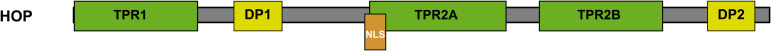
Canonical domain organization of HOP. HOP’s structure usually comprises three TPR domains called (TPR1, TPR2A, and TPR2B), a nuclear localization signal (NLS) that partially overlaps with the TPR2A domain and two DP sequences (DP1 and DP2).